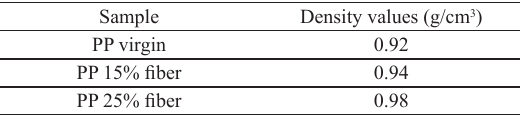
Table 5. Density values of composites and virgin PP. Sample